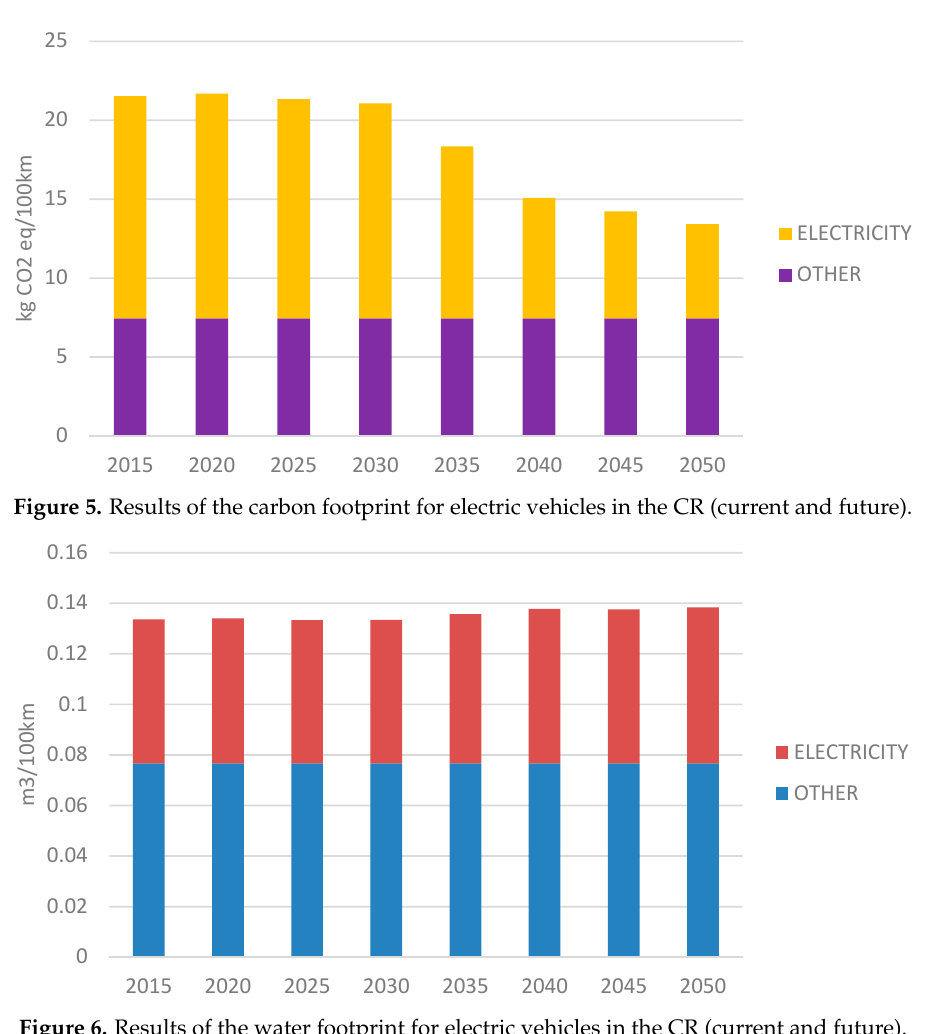
Figure 6. Results of the water footprint for electric vehicles in the CR (current and future).